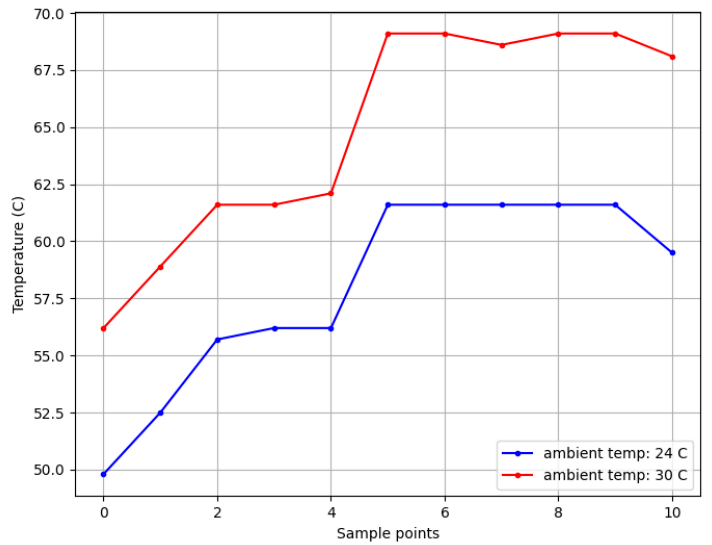
Figure 12. The processor’s operating temperature.